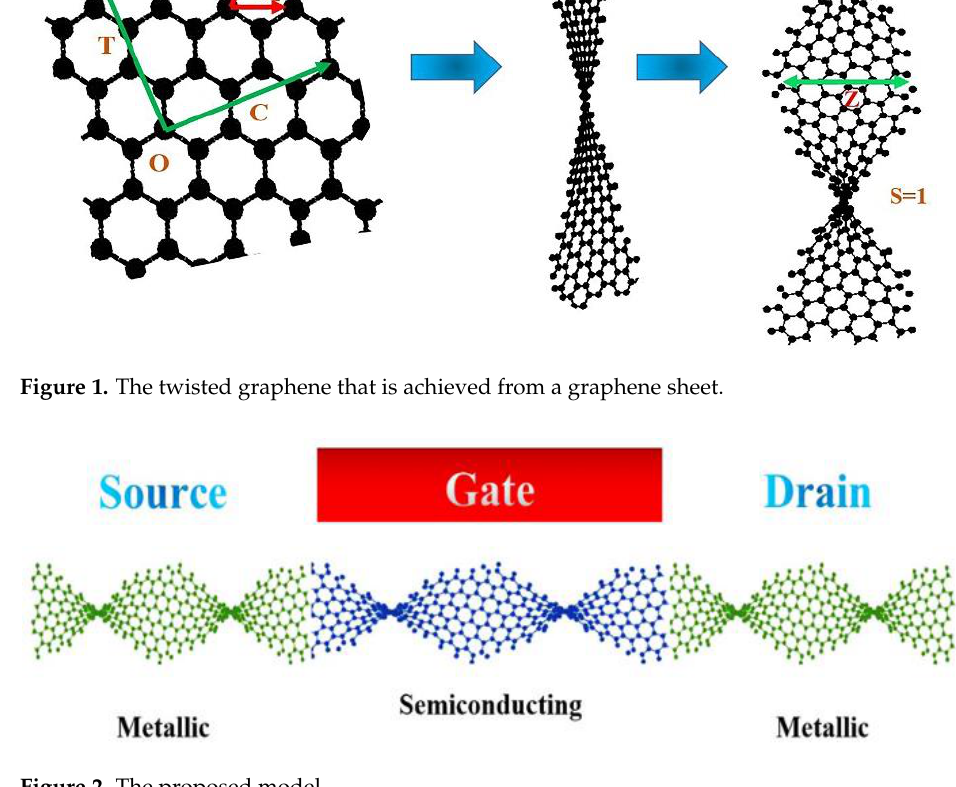
Figure 1. The twisted graphene that is achieved from a graphene sheet.